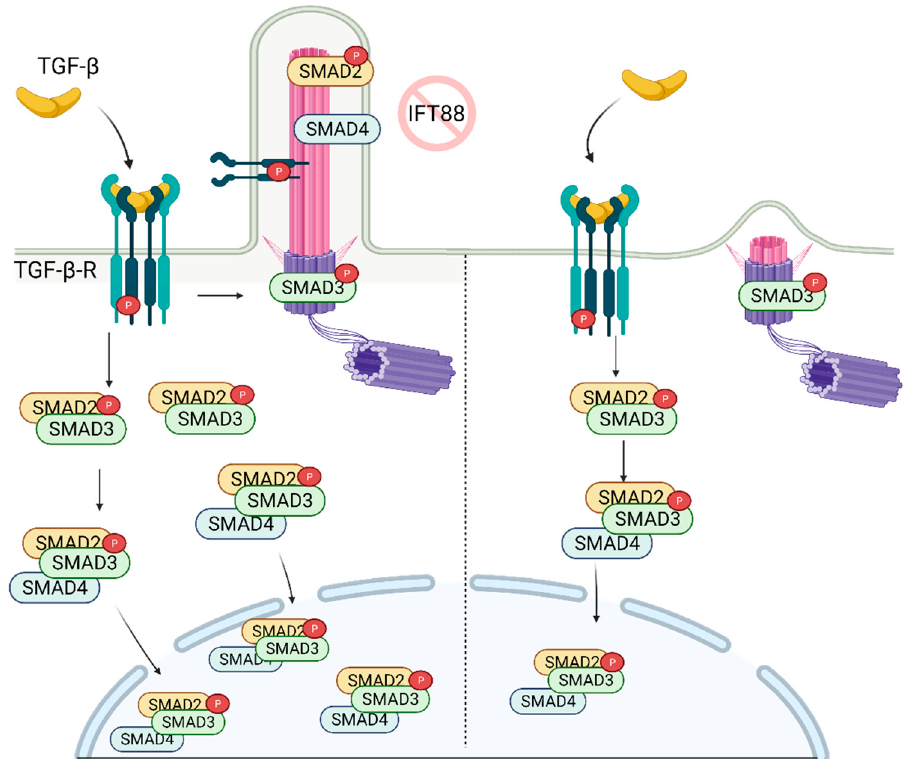
Figure 3. TGF- β signaling is regulated by primary cilia. In the presence of primary cilia, p-TGF- β -RI, p-SMAD2, and SMAD4 are localized on the cilia, while p-SMAD3 is localized on the ciliary base. Stimulation of the receptor with TGF- β ligand results in increased nuclear localization of active SMAD2/3/4 complex. In the absence of cilia, while p-SMAD3 is still localized on the ciliary base, its nuclear localization is diminished as well as the abundance of SMAD2/3 complex in the cell. Created with BioRender.com.